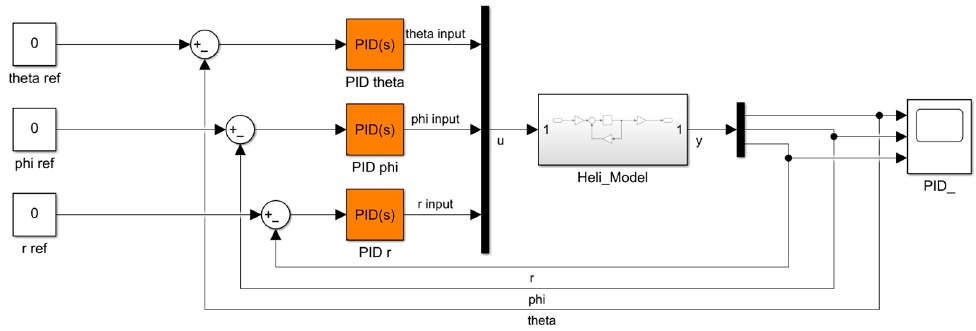
Figure 4. Multiloop PID Control Block Diagram